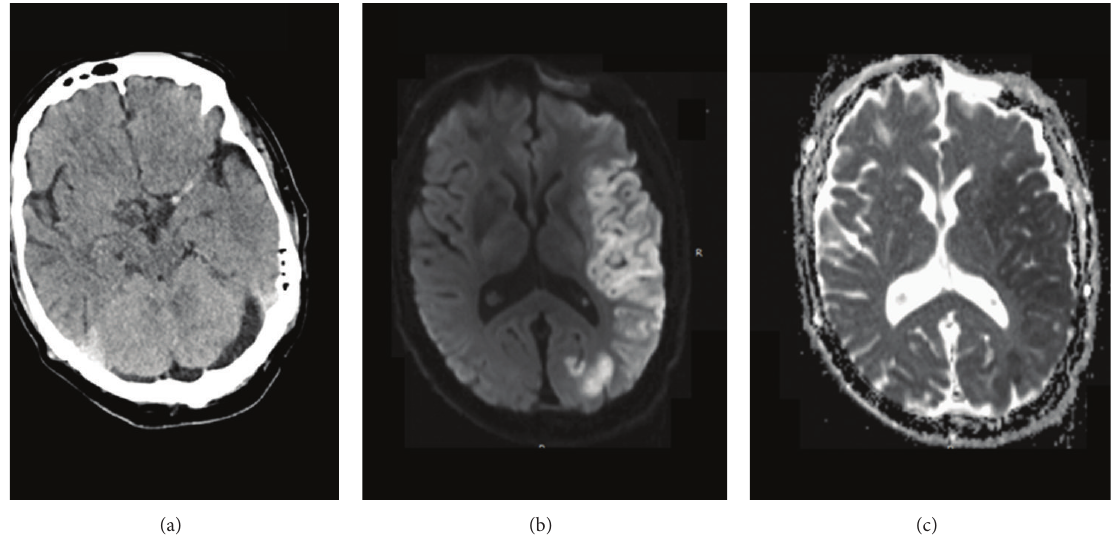
Figure 2: Hyperdense middle cerebral artery on the initial CT prior to intravenous tissue plasminogen activator (a). Diffusion-weighted magnetic resonance imaging (b). Apparent diffusion coefficient (c) confirms acute infarction in the left MCA